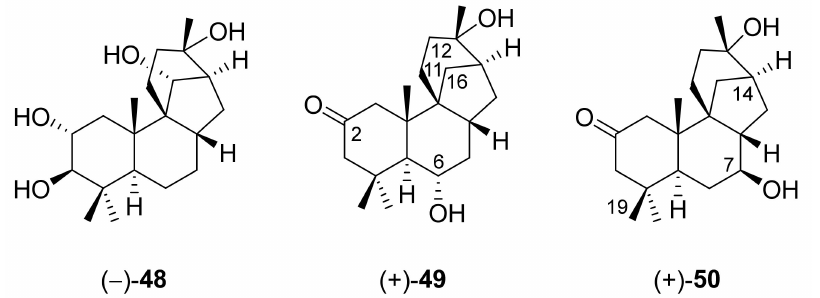
Figure 11. Stemodane diterpenoids biotransformation metabolites.